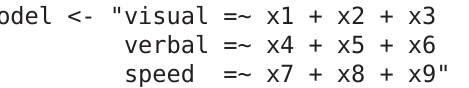
FIGURE 7 | The sampling distribution of FMI for factor loadings in MCAR. The panel rows correspond to sample sizes of N columns correspond to per variable missing rates of 20, 40, and 60%, or overall population missing rates of 10, 20, and 30%. The population FMI value in each panel is given as a vertical black dotted